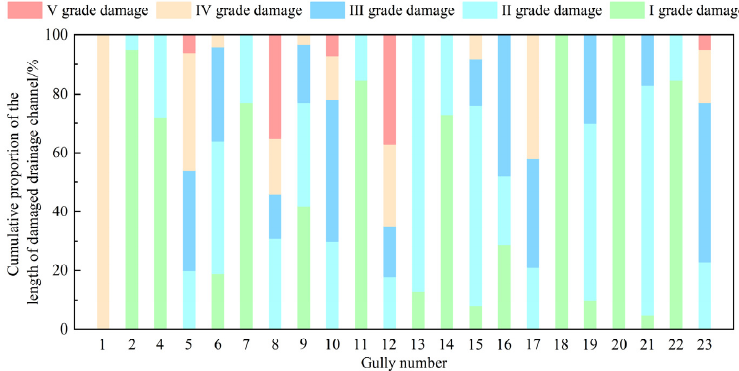
Figure 5. Damage grade division of drainage channels in PLR.